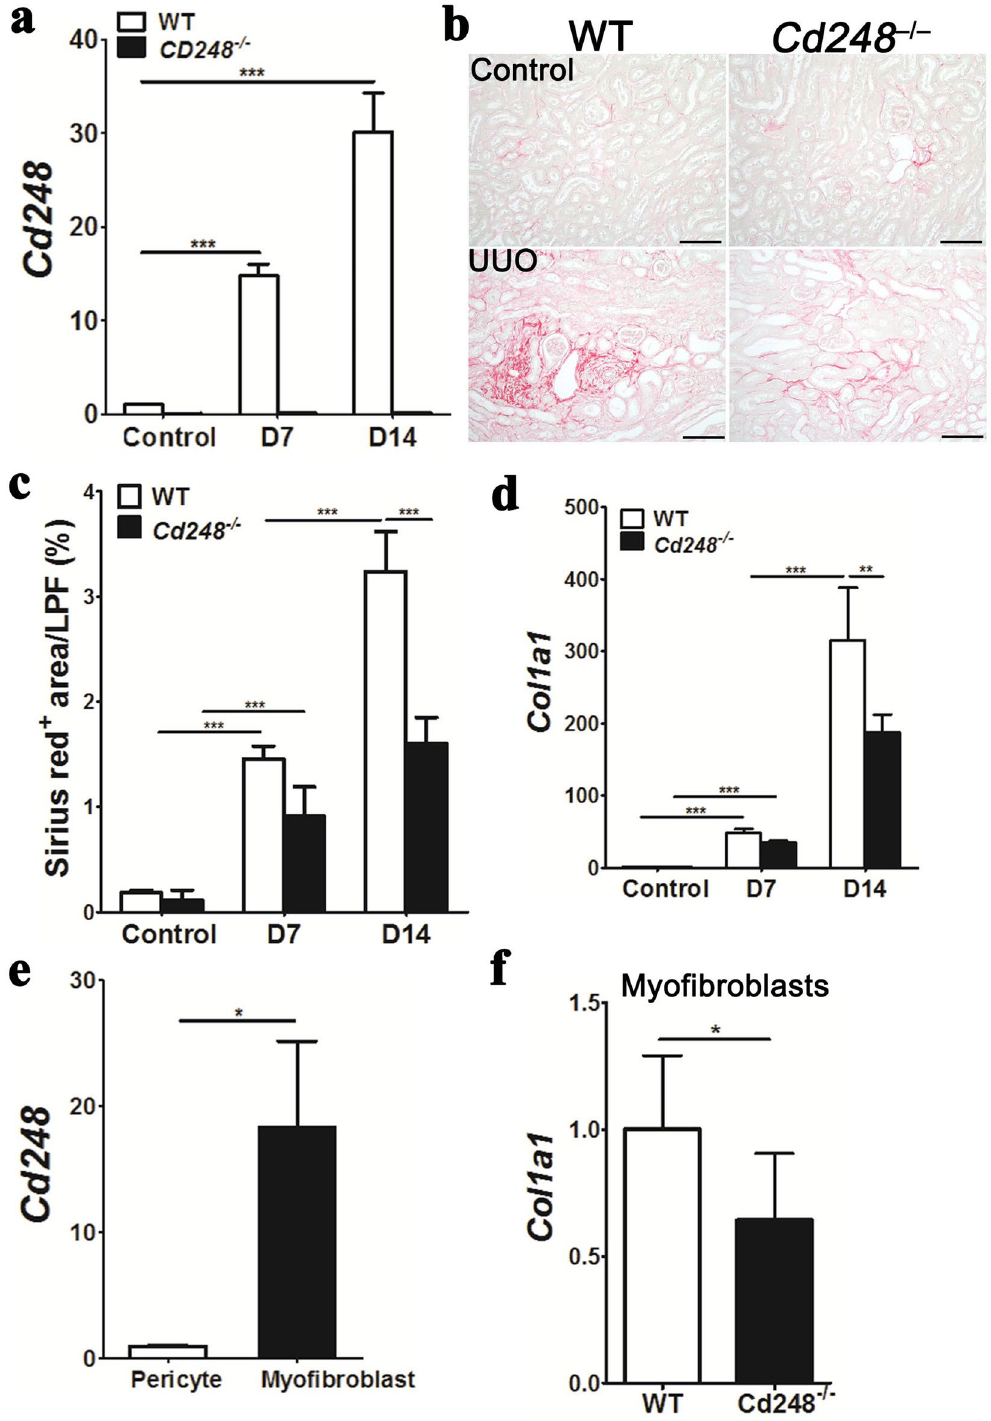
Figure 1. Cd248 disruption attenuated murine obstructive renal fibrosis. ( a ) Quantitative polymerase chain reaction (qPCR) of renal Cd248 in mice of wild type (WT) and CD248 knockout ( Cd248 –/– ) before (control), on day 7 (D7) and day 14 (D14) after unilateral ureteral obstruction (UUO) surgery. Cd248 expression was normalized by glyceraldehyde 3-phosphate dehydrogenase ( Gapdh ) and then compared with that of WT control. n = 10. ( b ) Representative images of picrosirius red staining in kidneys before (control) and on D14 after UUO surgery. Original magnification, × 100. Scale bar, 100 μm. ( c ) Quantification of Sirius red + collagen fibrils on low-powered field (LPF) images of kidney sections taken at 100× magnification. n = 10. ( d ) qPCR of renal Col1a1 , which encoded the collagen I α1 chain. n = 6–10. ( e ) qPCR of Cd248 in pericytes and myofibroblasts isolated from control and D7 UUO kidneys of Col1a1-GFP Tg mice, respectively. n = 6. ( f ) qPCR of Col1a1 in myofibroblasts isolated from D7 UUO kidneys of WT and Cd248 –/– mice. n = 6. Data are expressed as means ± standard errors of the mean. *** P < 0.001 by one-way ANOVA with post hoc Tukey’s multiple comparisons test in ( a , c , d ) and * P < 0.05 by unpaired t-test in ( e , f